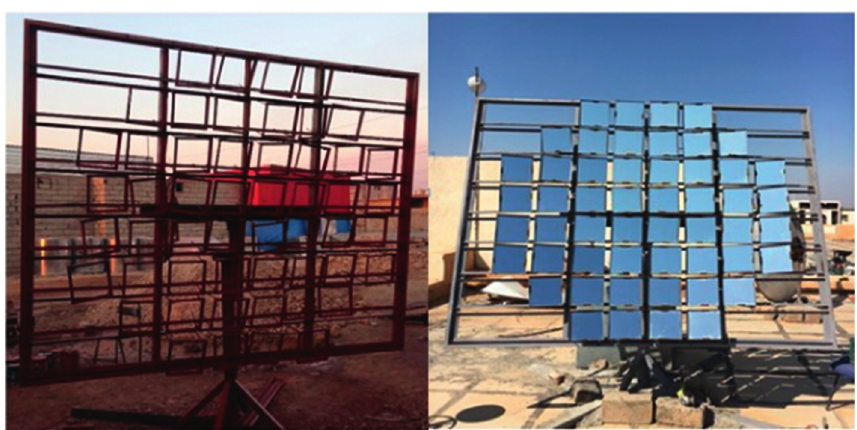
Figure 1: Concentrator before mirror is fixed and after mirror is fixed.